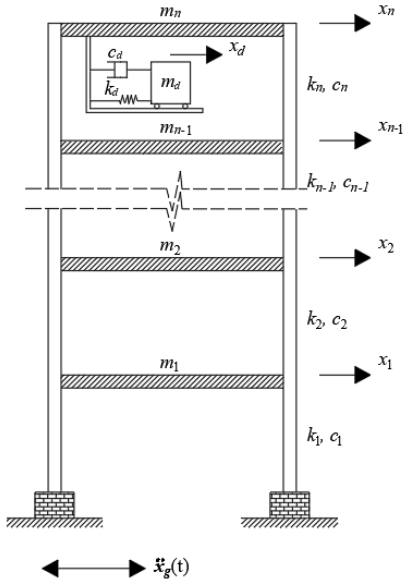
Figure 1. n -DOF system controlled via TMDs for seismic applications.